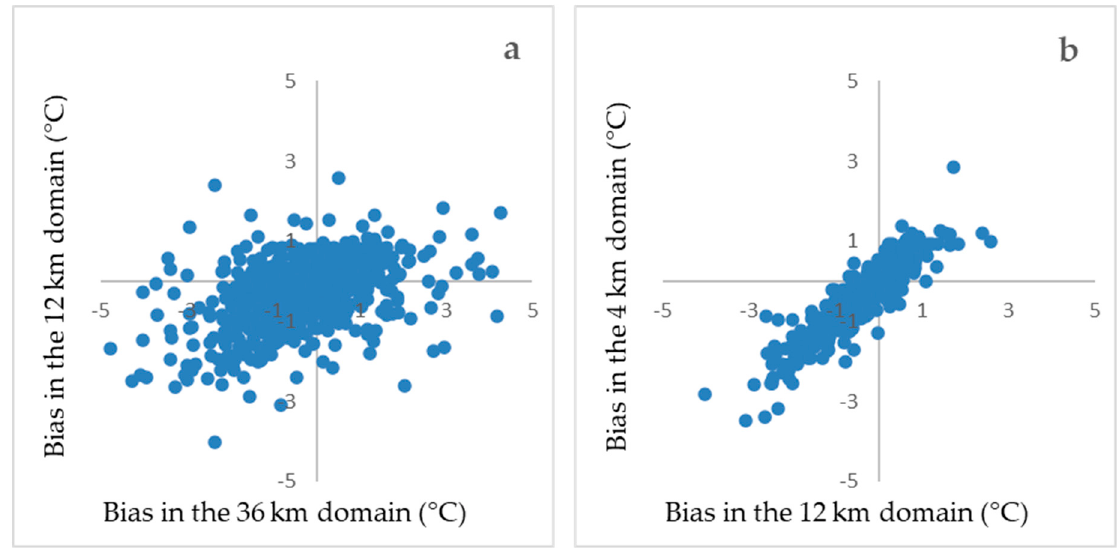
Figure 3. Scatter plots presenting ( a ) D1 ( x -axis) against D2 ( y -axis) and ( b ) D2 ( x -axis) against D3 ( y -axis) simulated annual temperature biases for all grids considered.